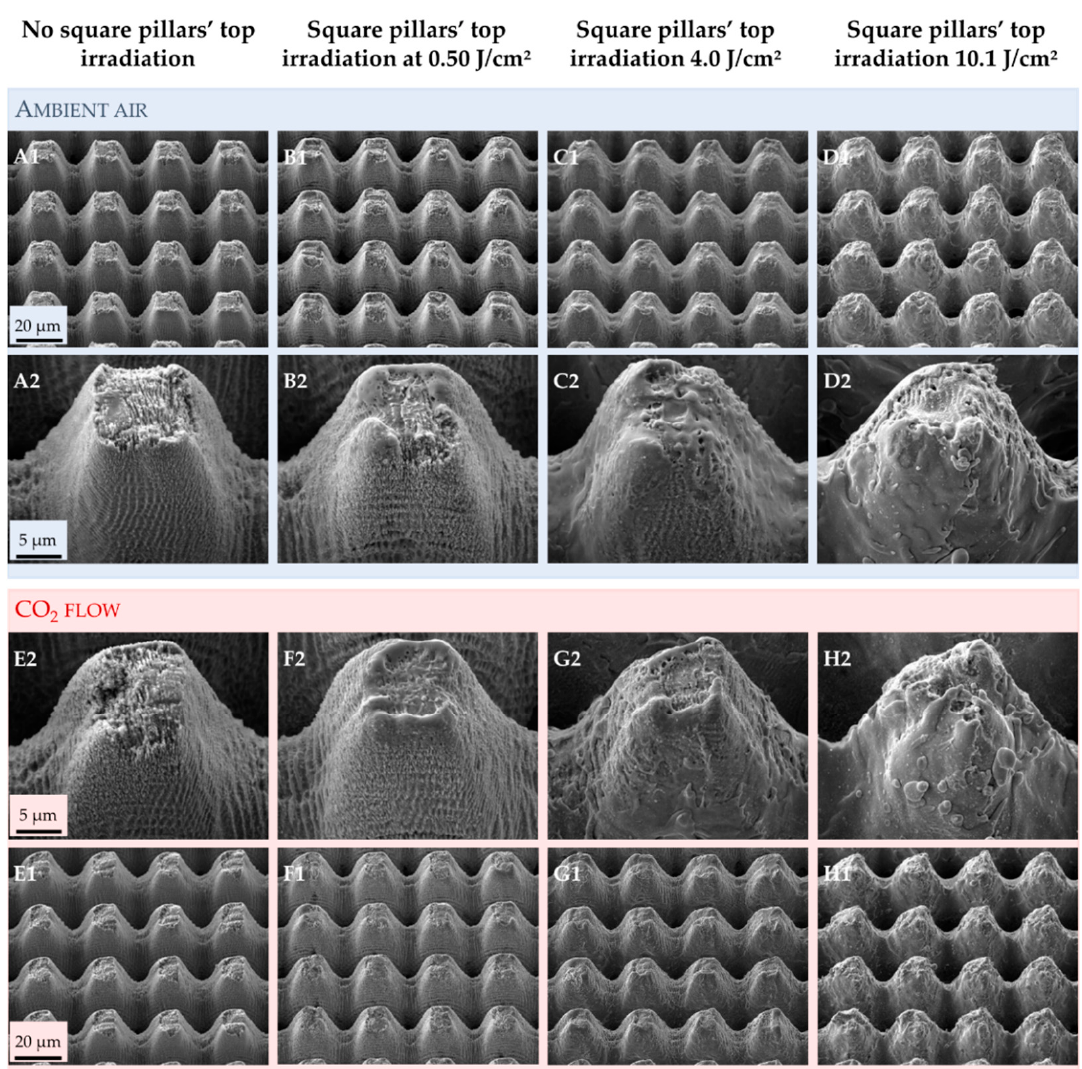
Figure 6. SEM images of the samples textured in ambient air or under a CO 2 flow for which the top of the square pillars was irradiated using different fluences. Images from ( A – D ) are samples textured in ambient air. Images from ( E – H ) are samples textured under a CO 2 flow. Images denoted with the number “1” are wide views of the textured area, while the number “2” is a focus on one square pillar from the wide view.